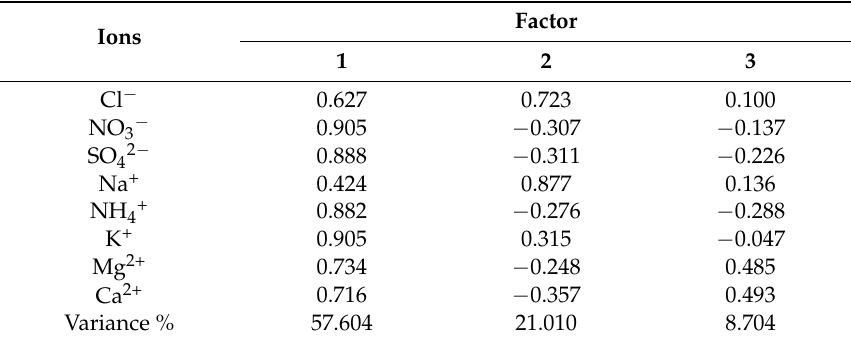
Table 3. Factor loading matrix for the elements in